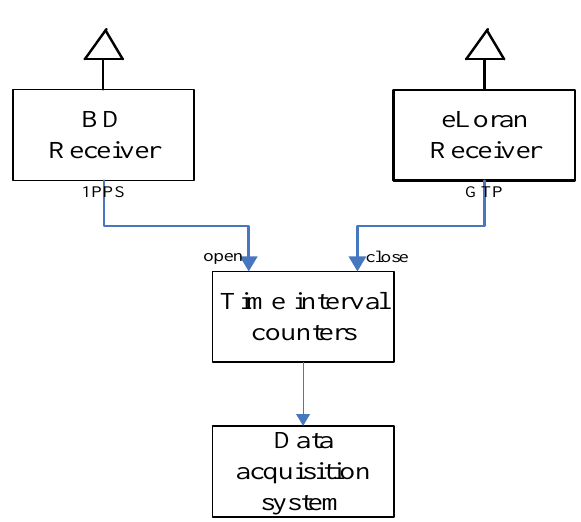
Figure 7. Measurement equipment connection.